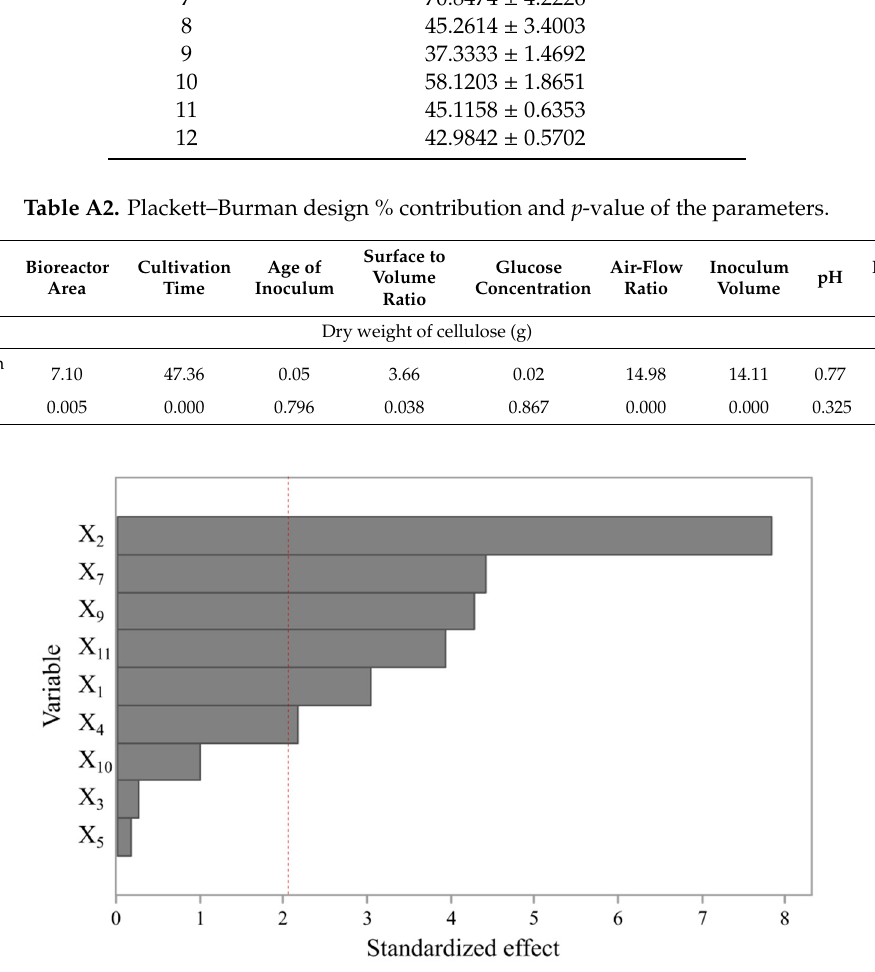
Figure A1. Pareto chart of the standardized e ff ects of process parameters on dry weight per surface unit. The impact of the bioreactor surface on dry weight per surface unit was highly reduced in comparison to the influence on the dry weight. That factor had a significant positive e ff ect on yield (g / m 2 ), but its contribution was only